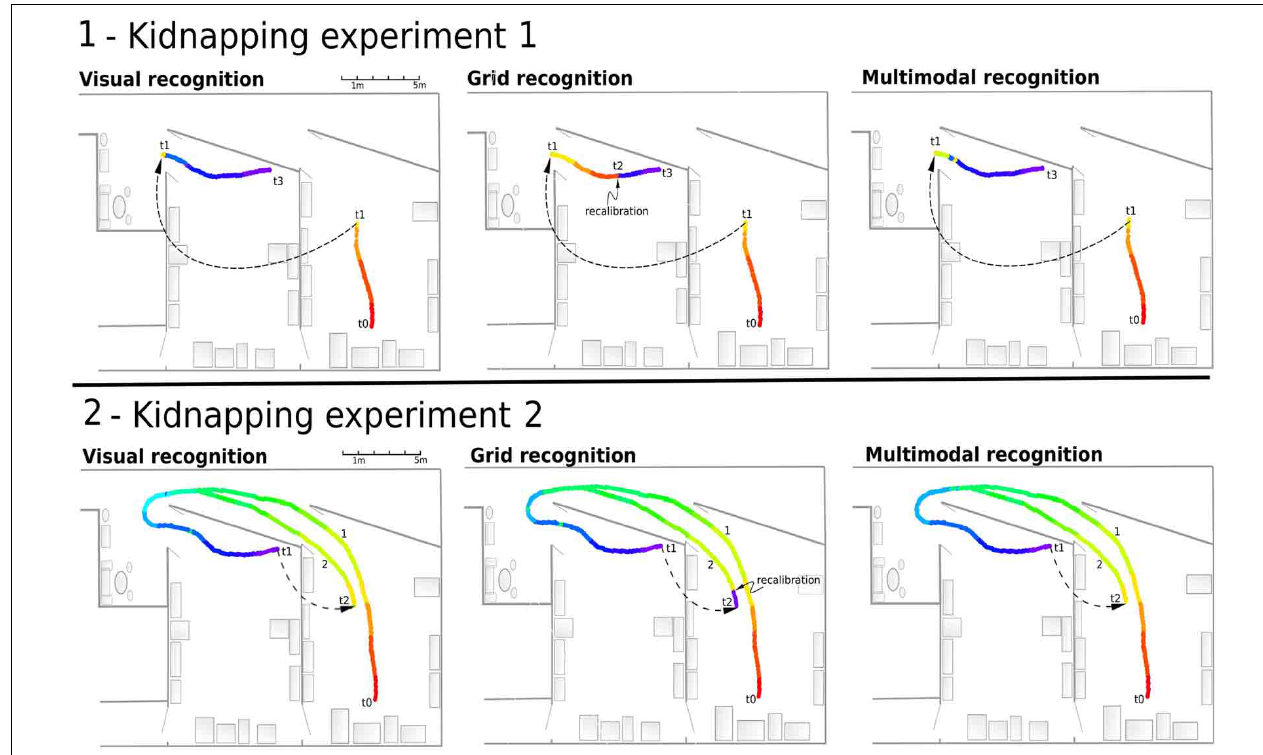
FIGURE 12 | (1) Experiment 10. Solving the kidnapping problem: The robot is remote-controlled from the starting point (t0) in a first room to (t1) in our laboratory. Next, it is kidnapped (blindfolded and lifted) and moved to an other room (t2). Then, the robot tries to localize itself while it is remote-controlled to the end (t1–t4). Left - Visual recognition during the experiment. The visual recognition system instantly localizes the robot after the kidnapping event. Middle - Grid recognition during the same experiment. Once kidnapped, grid recognition stays totally wrong since